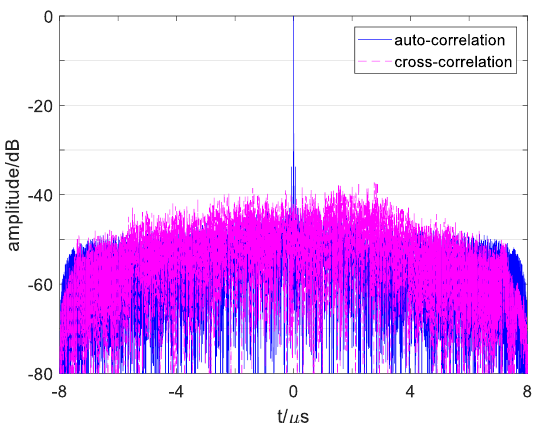
'' ss  during ' s and ' s + 34 2 1